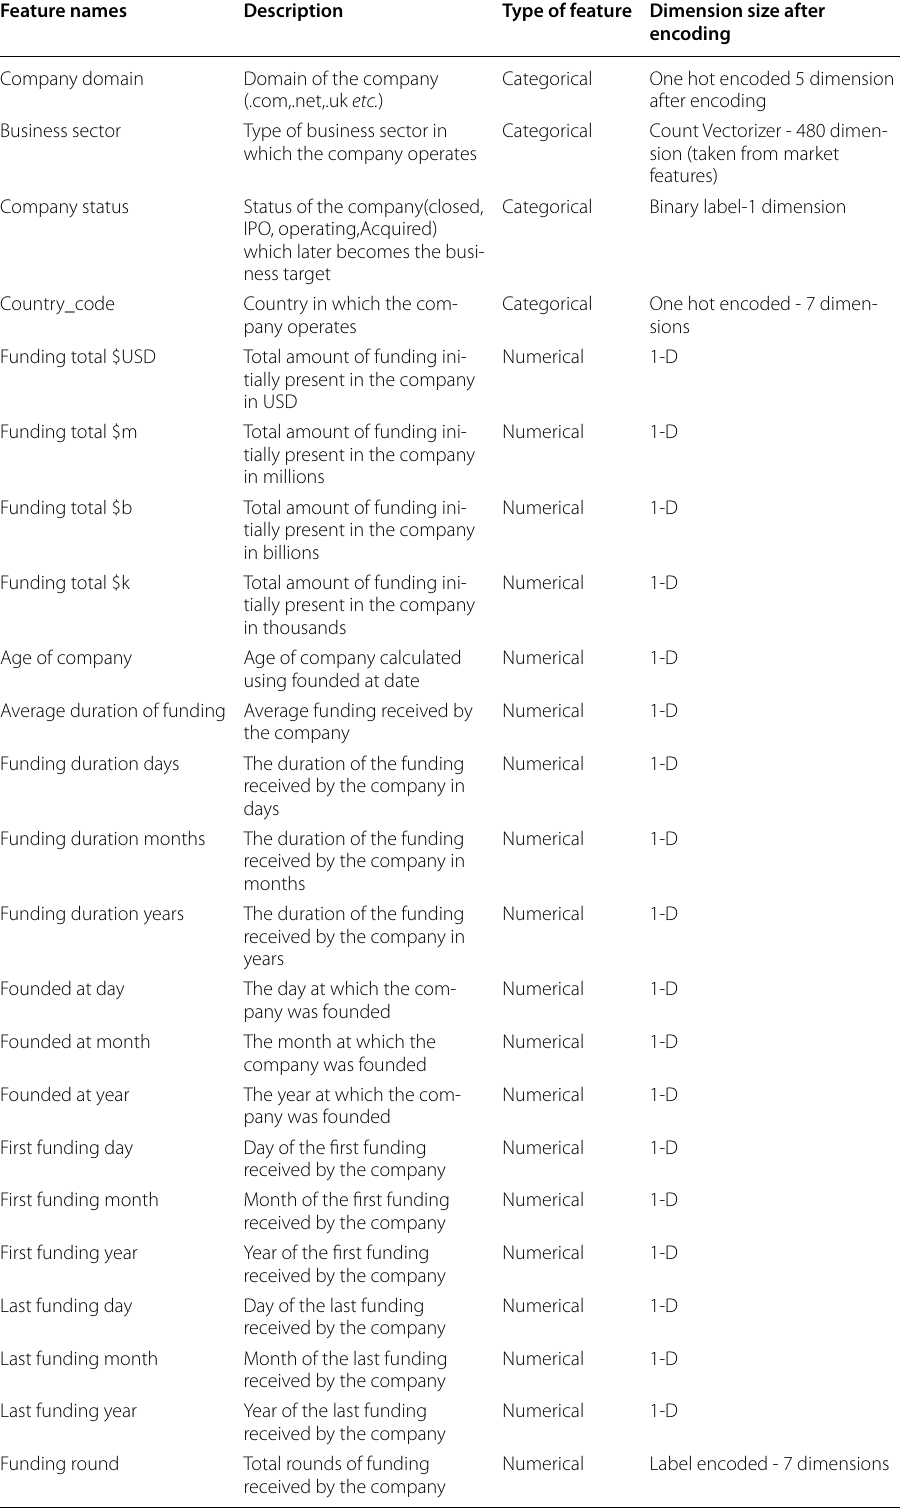
Table 2 A description of Business Features used in the prediction model Feature